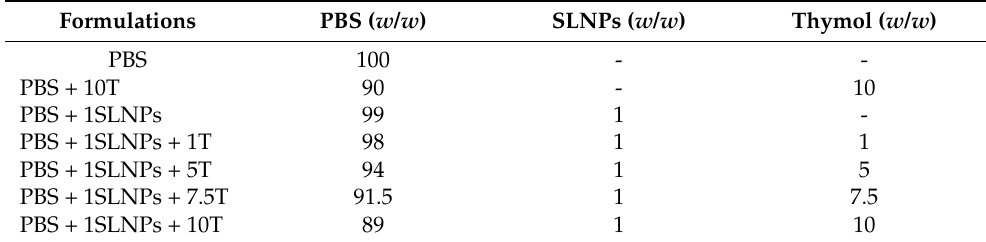
Table 1. PBS composite films’ formulations.